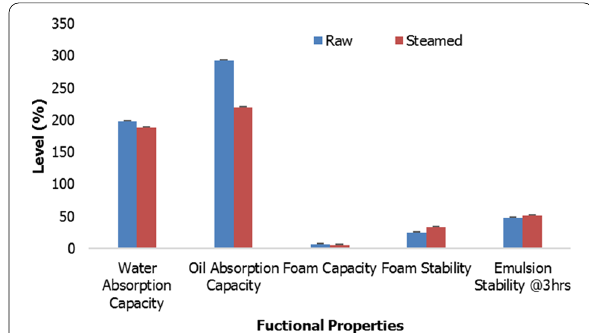
Fig. 3 Functional characteristic of raw and steamed edible part of T. fuscatus var